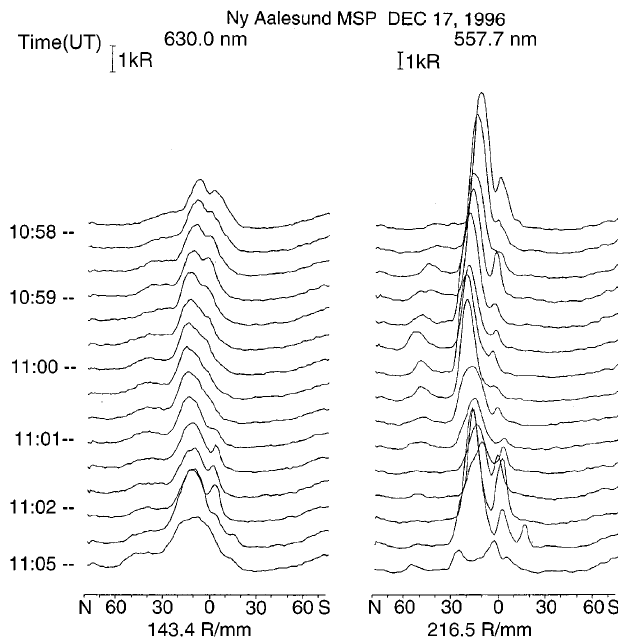
Fig. 1. Stacked plot observations of red- (630.0 nm) and green- (557.7 nm) line auroral emissions from the meridional scanning photometer at Ny A ˚ lesund made around 1100 UT on 17